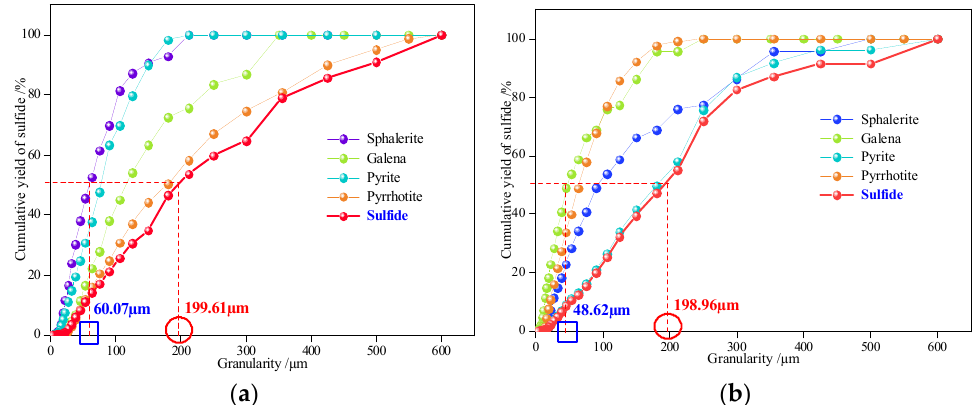
Figure 7. The granularity dissemination of most of the sulfide minerals and aggregates. ( a ) − 0.074 mm (48%); ( b ) − 0.074 mm (69%).